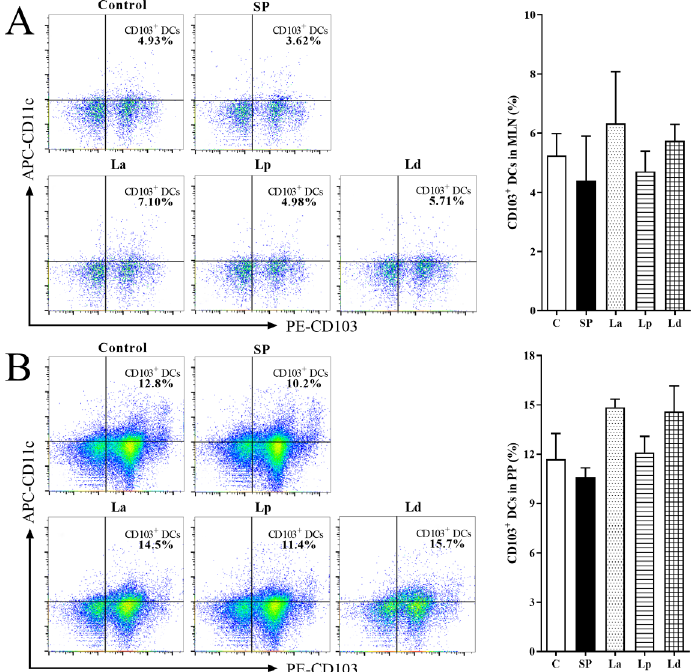
Figure 3. Effect of Lactobacillus on the percentage of DCs in the MLNs ( A ) and PPs ( B ) of soy-aller-